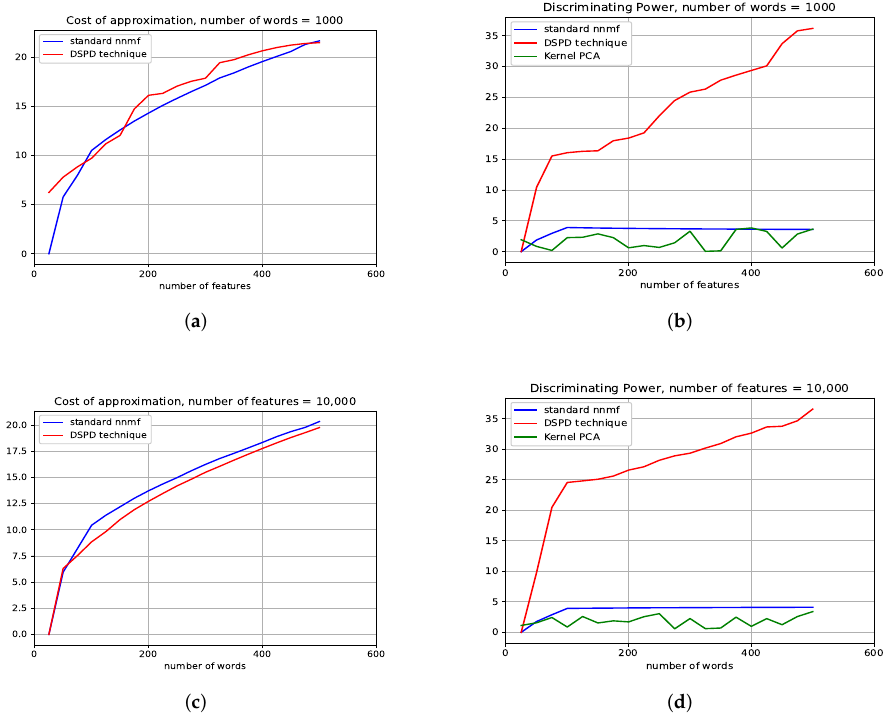
Figure 2. Behavior of the technique with respect to standard nnmf methods in terms of Cost of Approximation ( a , c ), and Discriminating Power ( b , d ), by changing the number of words ( a , b ), and the number of features ( c , d